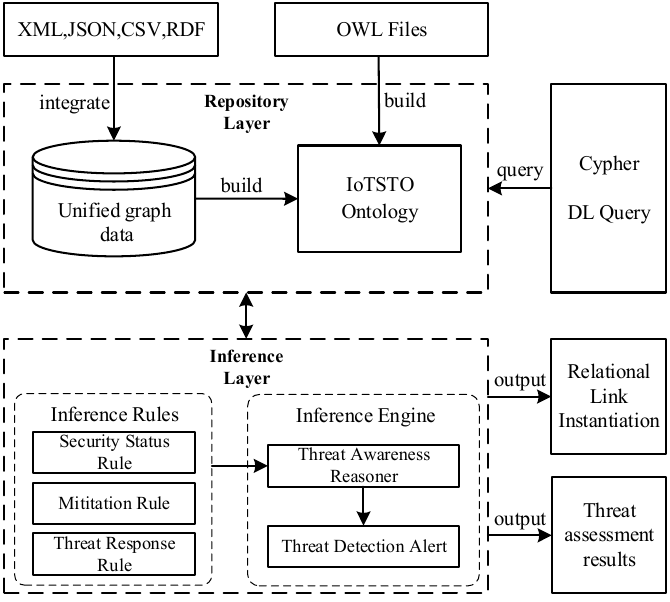
Figure 2. Multi-source knowledge reasoning framework for IoT security.